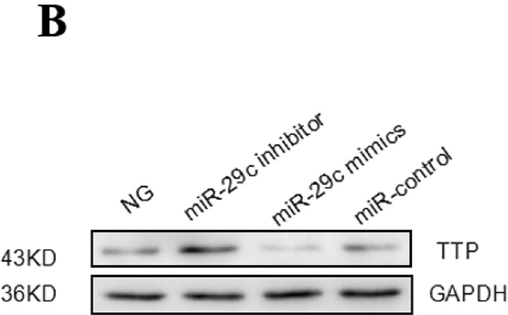
Figure 1. miRNA-29c targets TTP. ( A ) The expression of miRNA-29c in podocytes transfected with mimics (30 nM) or inhibitors (100 nM) for 6 h. ( B ) Western blot analysis showed the expression of TTP in podocytes transfected with mimics or inhibitors for 36 h. ( C ) The quantified Western blot data shown in graph format. ( D ) qRT-PCR analysis of TTP mRNA expression in podocytes transfected with mimics or inhibitors. ( E ) Podocytes were transfected with miRNA-29c inhibitor (100 nM) and treated with HG (25 mM) for 36 h as compared with NG. ( F ) The quantified Western blot data shown in graph format. ( G ) qRT-PCR analysis of TTP mRNA expression in podocytes transfected with miRNA-29c inhibitors (100 nM) and treated with HG (25 mM) for 24 h. Results were obtained from three independent experiments. The data are shown as mean ± SEM. * P < 0.05 compared with control. #P < 0.05 compared with high